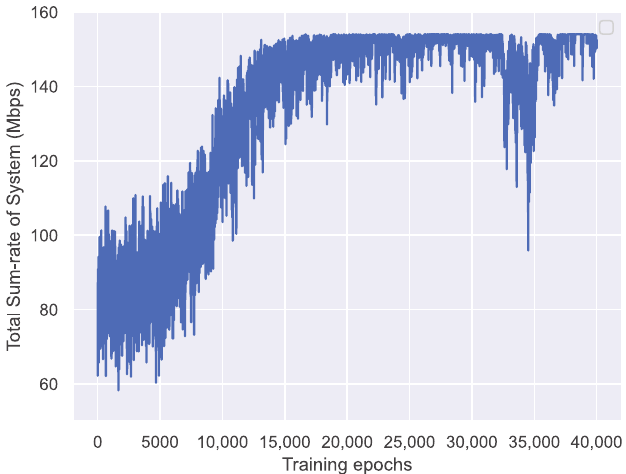
Figure 6. Training results at different learning rates.